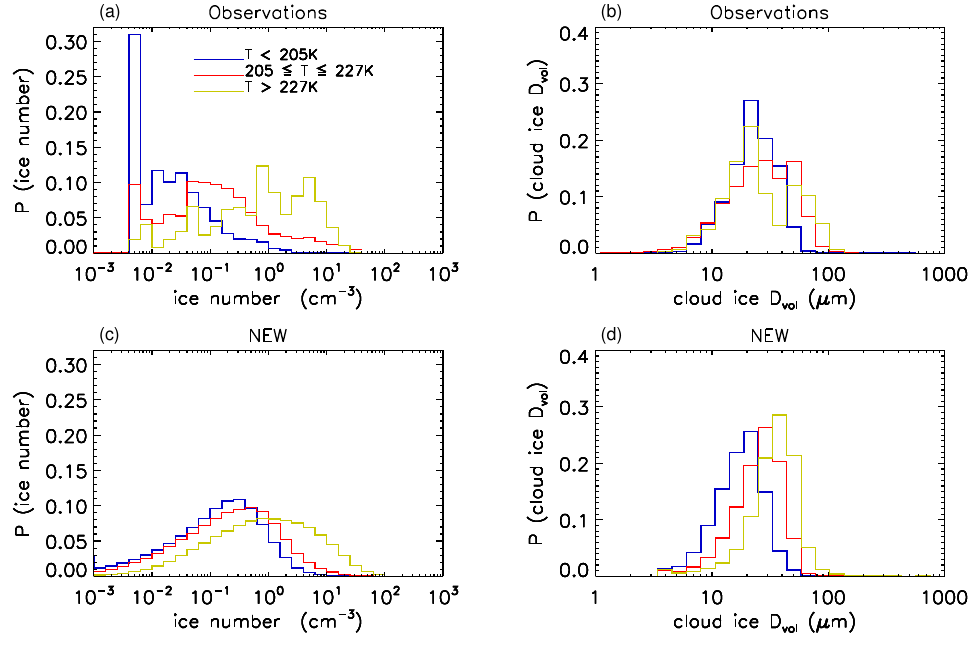
Fig. 7. Global PDF of cloud ice volume mean diameter ( D vi ) and in-cloud ice number concentration and for various temperature ranges compiled from aircraft observations (Kr¨amer et al., 2009) and from the NEW run. Only ice clouds are considered, while mixed-phase clouds containing liquid have been excluded from this